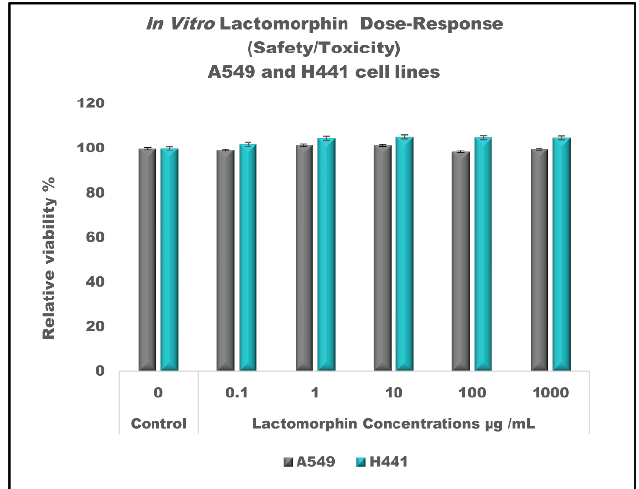
Figure 13. Resazurin assay results of the cell viability experiment after the exposure to different concentrations of Lactomorphin for A549 and H441 cell lines. concentrations of Lactomorphin for A549 and H441 cell